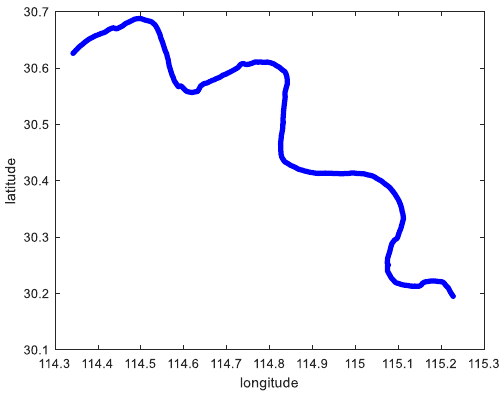
Figure 11. The original trajectory of scenario 2.